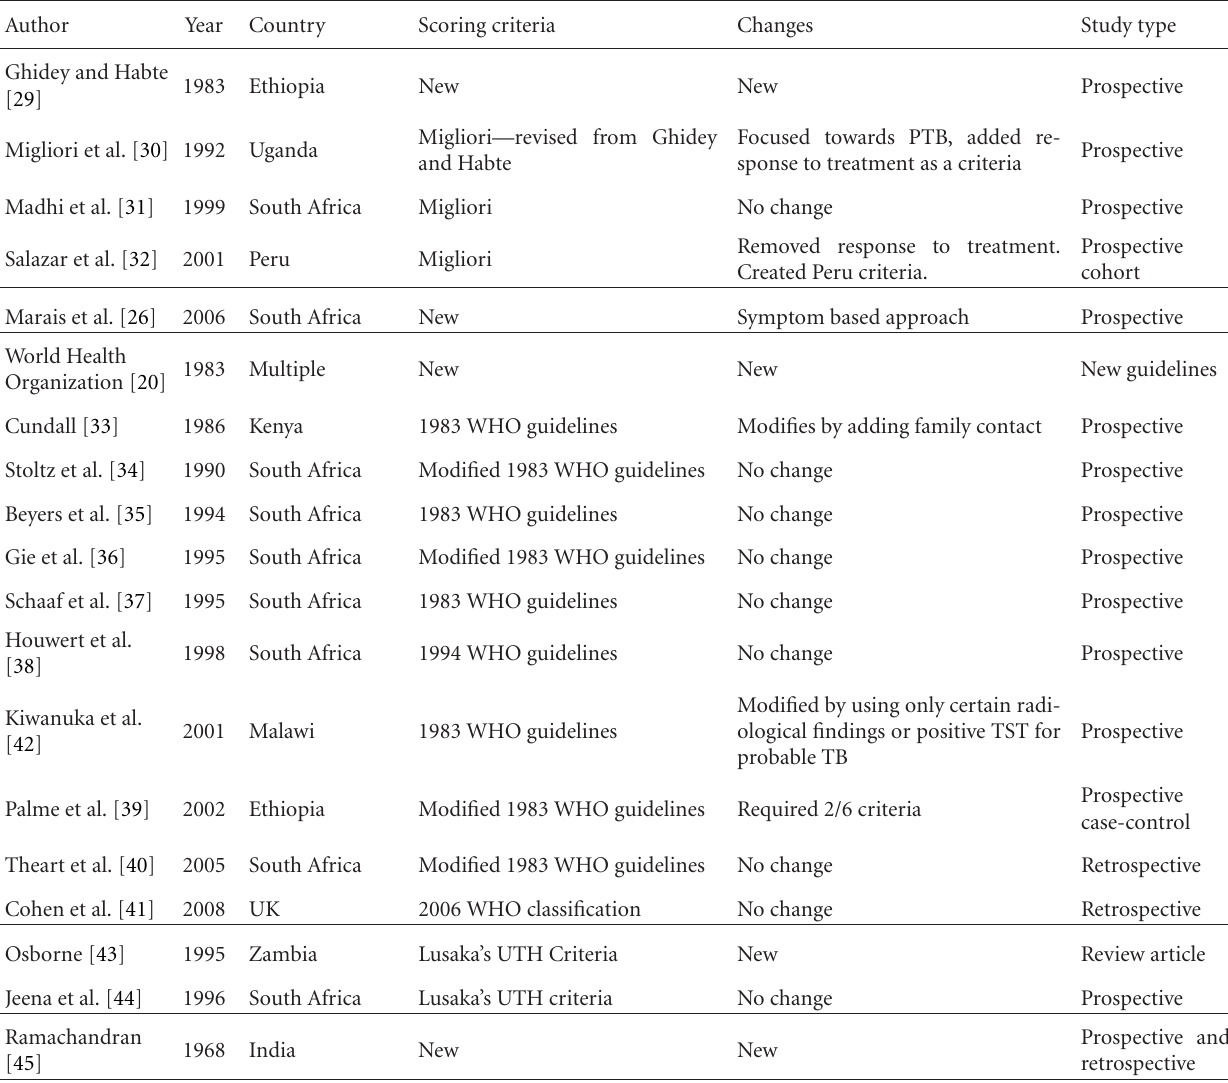
Table 2: Diagnostic classifications and studies evaluating these classifications.